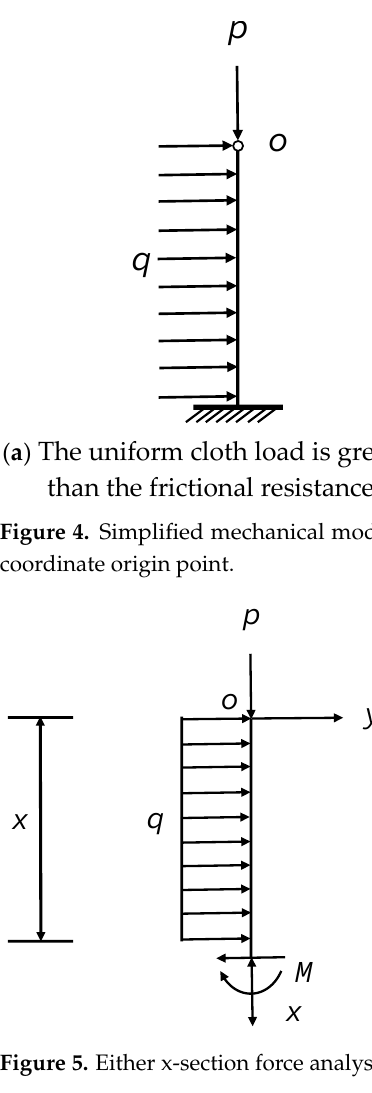
P -top plate pressure,